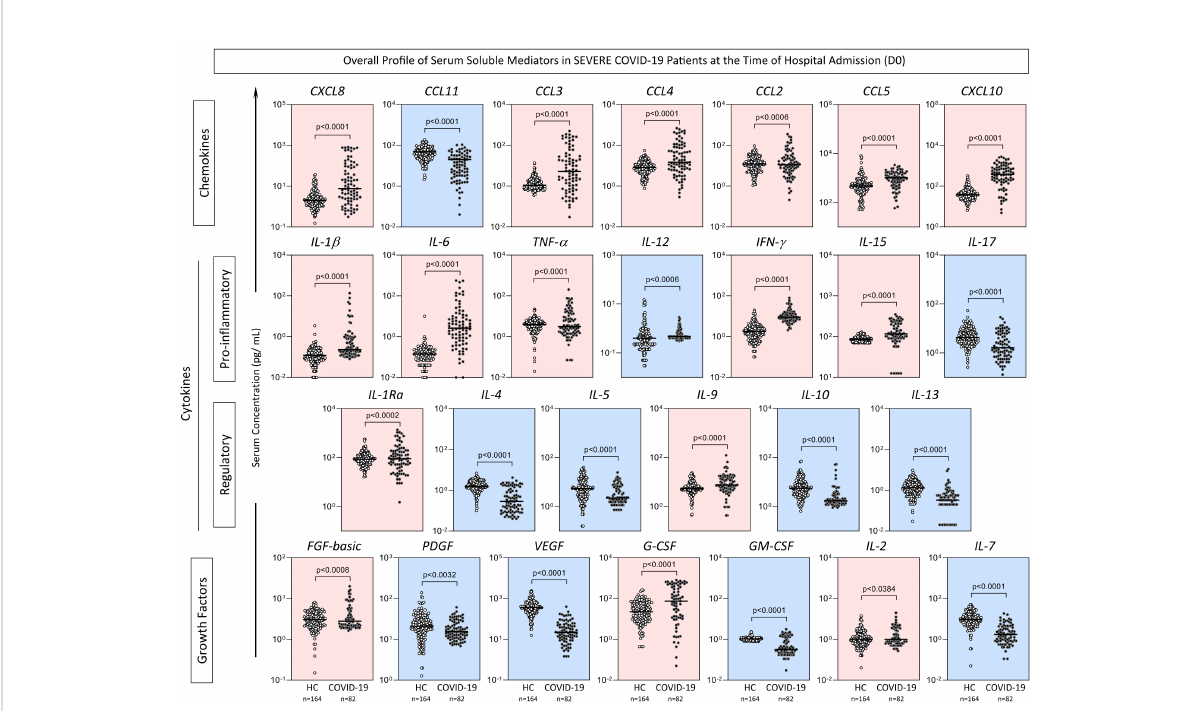
FIGURE 1 Overall pro fi le of serum soluble mediators in severe COVID-19 patients on hospital admission (D0). Serum levels of chemokines (CXCL8, CCL11, CCL3, CCL4, CCL2, CCL5, CXCL10), pro-in fl ammatory cytokines (IL-1 b , IL-6, TNF- a , IL-12, IFN- g , IL-15, IL -17), regulatory cytokines (IL-1Ra, IL- 4, IL-5, IL-9, IL-10, IL-13) and growth factors (FGF-basic, PDGF, VEGF, G-CSF, GM- CSF, IL-2, IL-7) were measured in COVID-19 patients on hospital admission (D0, n=82) and non-infected pre-pandemic Healthy Controls (HC, n=164) by high-throughput multiplex bead array as described in Material and Methods. The results are presented as scattering distribution of individual values (pg/mL) in log scale with lines showing the median values. Comparative analysis between COVID-19 vs HC was performed by Mann-Whitney test and signi fi cant differences at p<0.05 underscored by connecting lines and p values provided in the fi gure. Colored backgrounds highlight decreased (blue) or increased (pink) levels of serum soluble mediators in COVID-19 as compared to